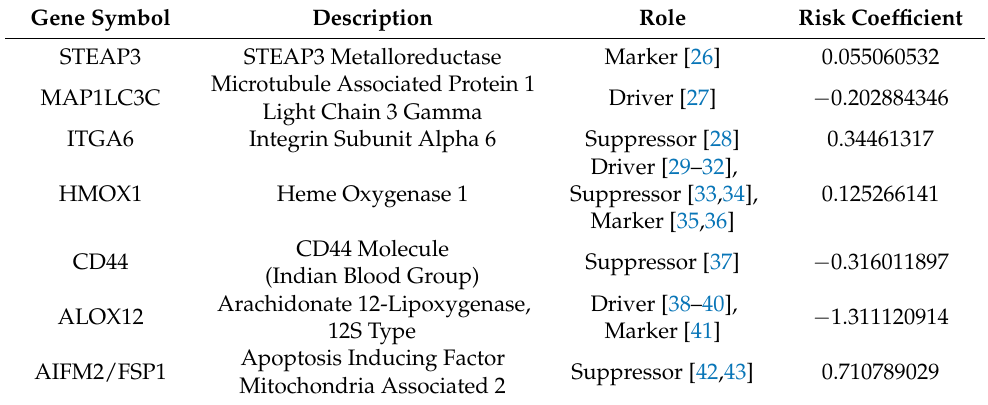
Table 3. 7 ferroptosis-related prognostic genes obtained from LASSO Cox regression